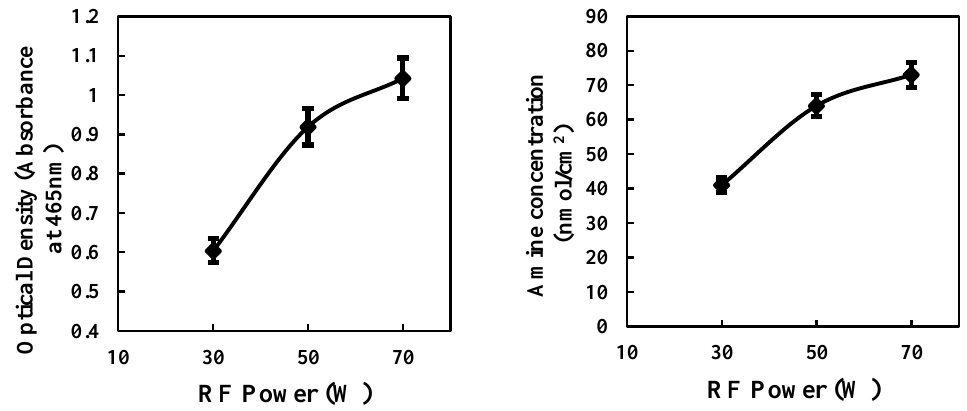
Figure 3. Optical density values of methyl orange solution ( left ) and amine concentrations on the titanium surface ( right ) with increasing radio frequency (RF) plasma powers.